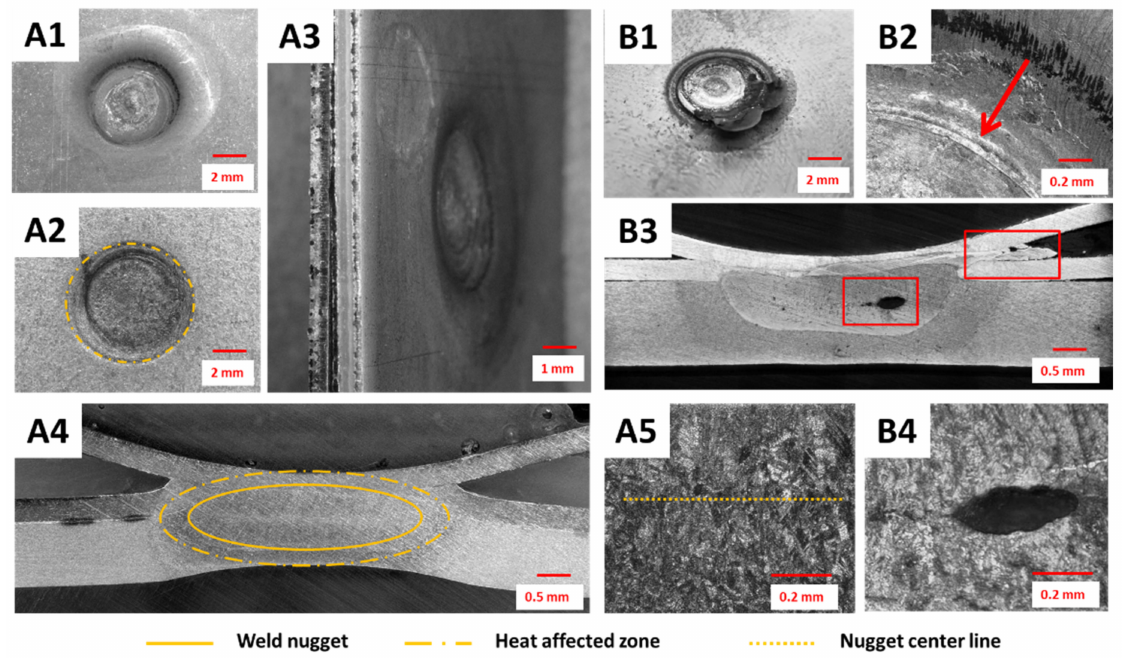
Figure 7. Examples of spot welds fabricated by shunt current-assisted RSW properly: ( A1 ) top view, ( A2 ) bottom view, ( A3 ) side view, ( A4 ) cross-section at low magnification, and ( A5 ) weld nugget at high magnification) and non-properly formulated: ( B1 ) top view, ( B2 ) top view magnified, ( B3 ) cross-section at low magnification, and ( B4 ) weld nugget at high magnification.